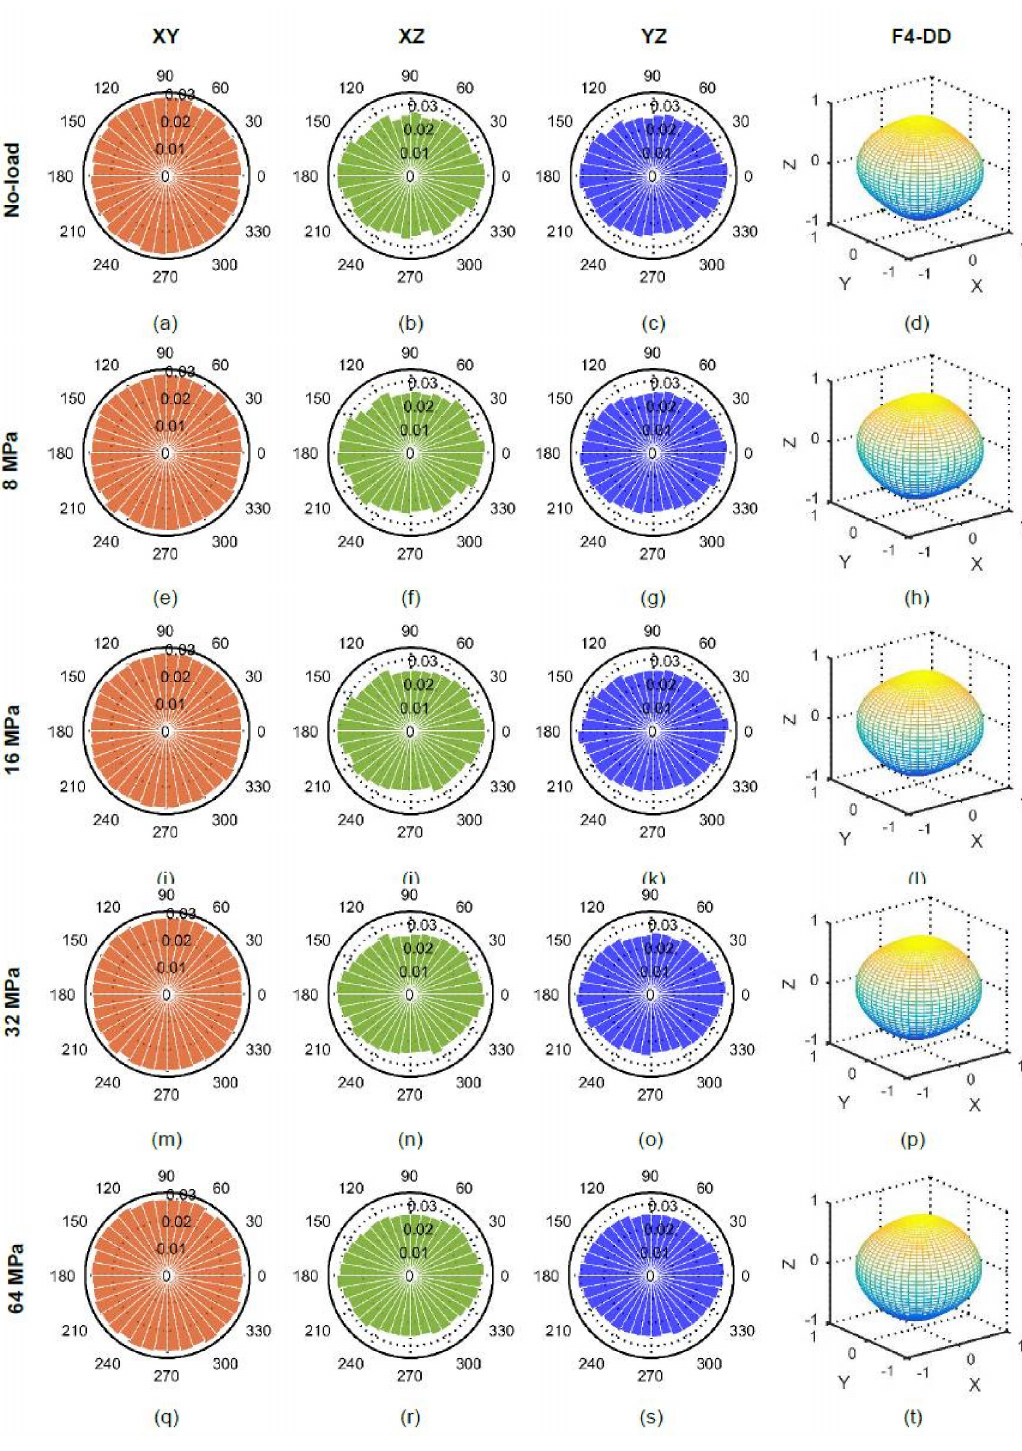
Figure 19. Branch vectors of RBS particles at different vertical stresses (F4-DD: 4th order approximation of distribution